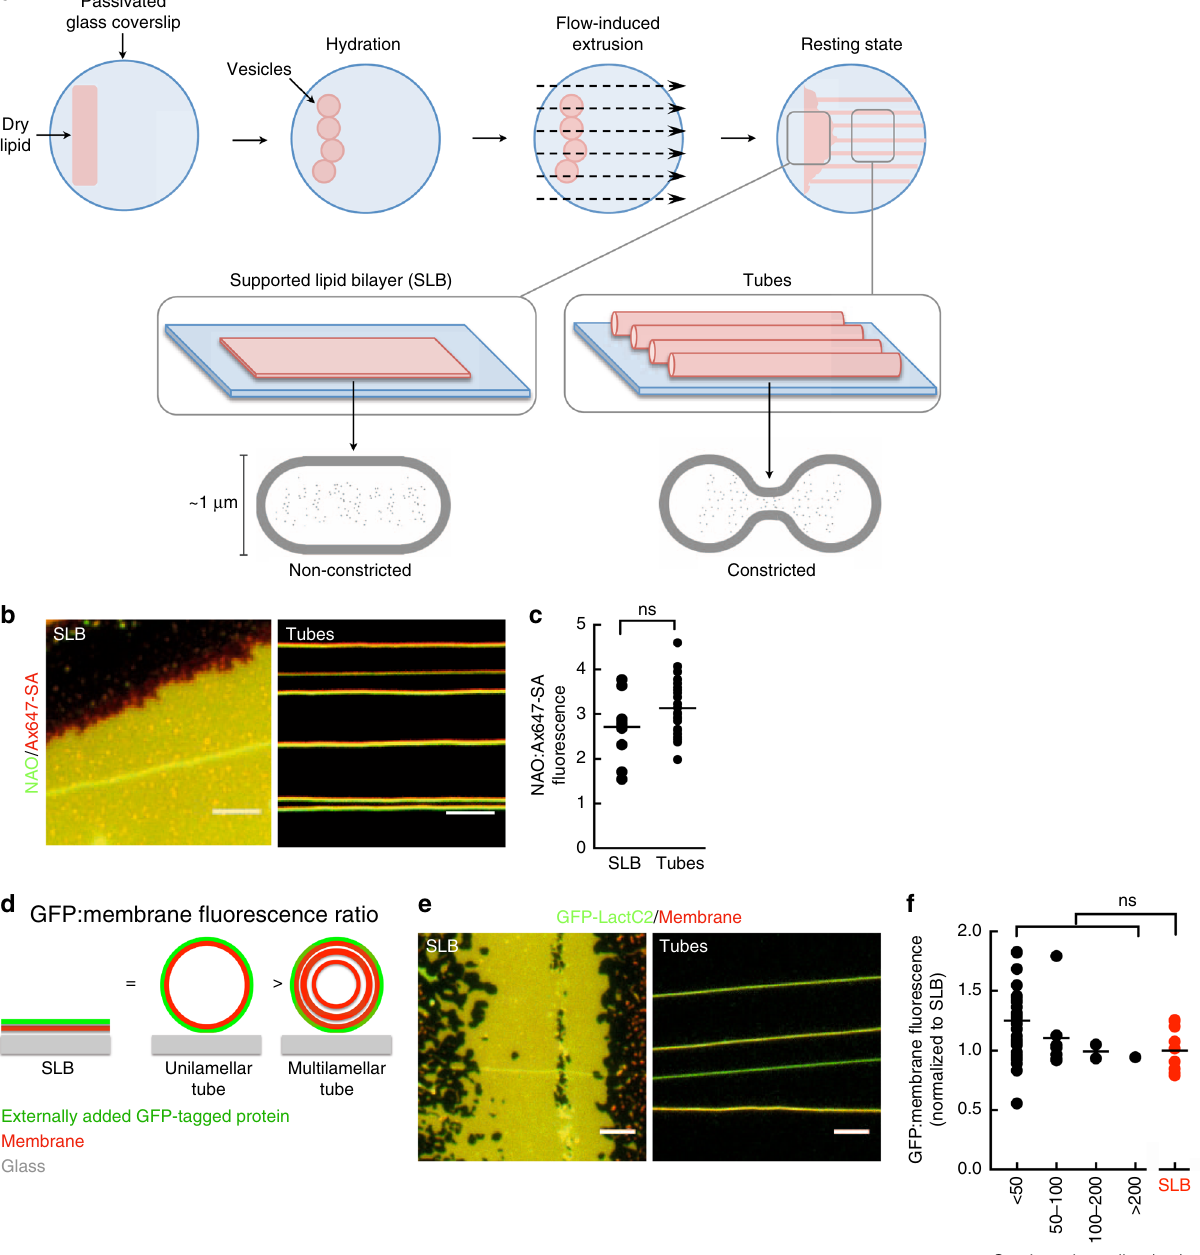
Fig. 4 Template characteristics. a Schematic of the membrane template. b Representative images of NAO and Alexa647-labeled streptavidin (SA) fl uorescence on the SLB and tubes composed of CL:DOPC (25:75 mol%). Scale bar = 10 µ m. c Ratios of NAO and Alexa647-labeled streptavidin (SA) fl uorescence on the SLB and tubes composed of CL:DOPC (25:75mol%); ns, not signi fi cant, Mann – Whitney test. n (SLB) = 19 and n (tube) = 25 samplings from a single template preparation. d Schematic showing the expected fl uorescence ratios of an externally added GFP-tagged protein that binds the membrane on the SLB, unilamellar and multilamellar tubes. e Representative images showing GFP-LactC2 distribution on the SLB and tubes. Scale bar = 10 µ m. f Ratios of GFP-LactC2 and membrane fl uorescence on tubes of varying sizes compared to that seen on the SLB; ns, not signi fi cant, Mann – Whitney test. n (<50 nm) = 33, n (50 – 100 nm) = 8, n (100 – 200 nm) = 2, n (>200 nm) = 1, and n (SLB) = 10 samplings from a single template